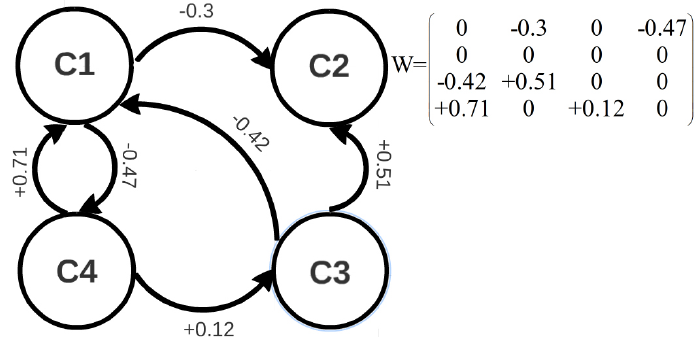
Figure 1. A 4-node FCM with its weight